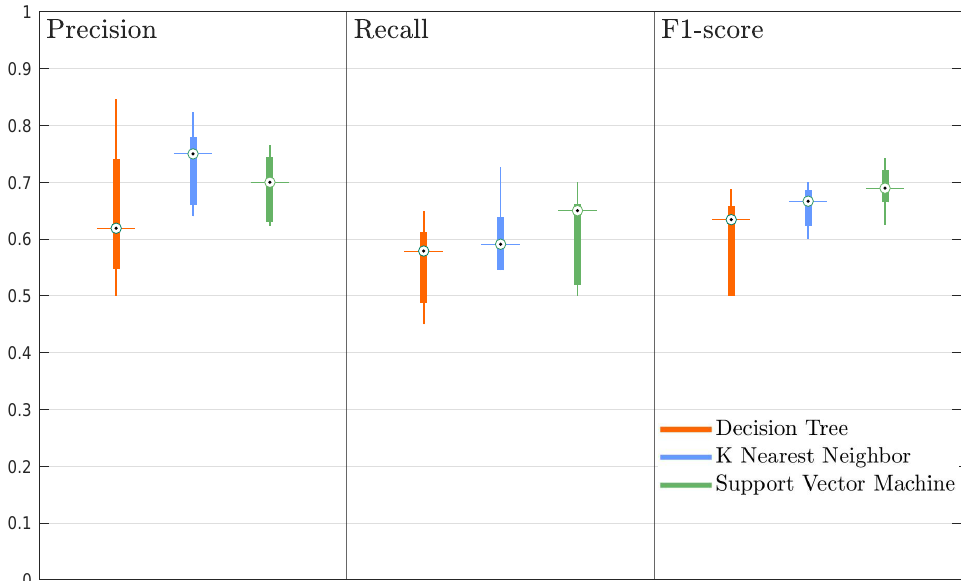
Figure 6. Workflow III. Boxplot of precision, recall, and f1 score distributions on test sets for weld defective class among three classifiers performing on ’feature selection’